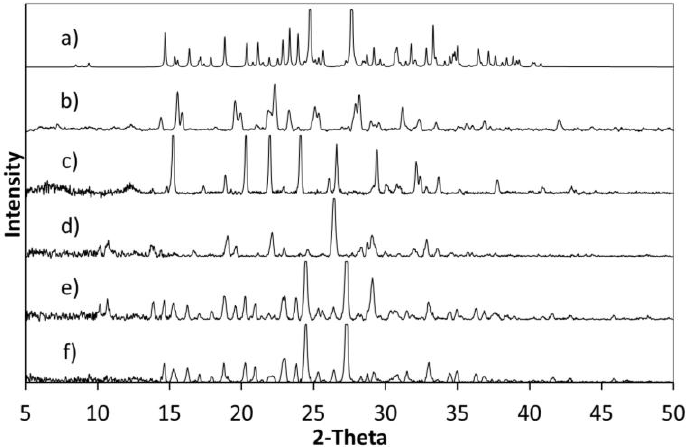
Figure 2. ( a ) PXRD pattern generated from the single crystal determined structure of 5FC-4Cl35DNBA for comparison with PXRD patterns of ( b ) 4Cl35DNBA; ( c ) 5FC; and products of evaporative crystallisation of 5FC: 4Cl35DNBA in various ratios: ( d ) 1:2; ( e ) 2:1; and ( f ) 1:1 (all crystallisations in ethanol and water 1:1 by volume).